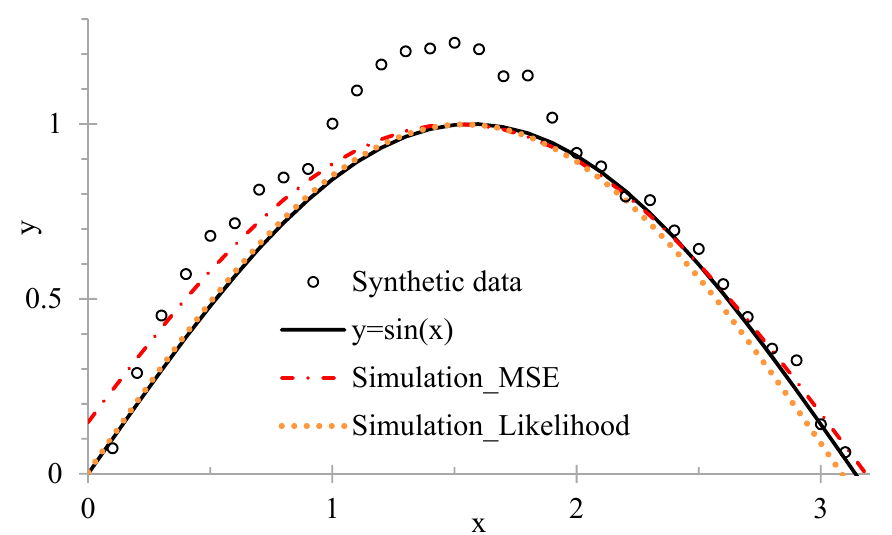
Figure 1. Comparison between the synthetically generated data and the simulated results for model calibration criteria of mean squared error (MSE) and Likelihood.